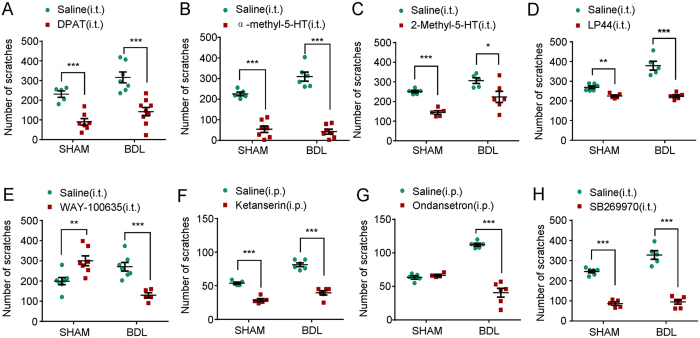
The effects of 5-HT receptors agonists or antagonists on 5-HT-induced scratching behavior in sham and BDL rats.(A–D) Scratching behavior induced by i.d. injection of 5-HT (200 μg) into the nape of the neck was significantly suppressed by intrathecal (i.t.) injection of 5-HT1A receptor agonist DPAT (A) 10 μg, 5-HT2 receptor agonist α-methyl-5-HT (B) 10 μg, 5-HT3 receptor agonist 2-Methyl-5-HT (C) 10 μg, 5-HT7 receptor agonist LP44 (D) 10 μg in sham and BDL rats (n = 6–8 per group). (E) Intrathecal (i.t.) injection of 5-HT1A receptor antagonist WAY-100635 (10 μg) increased 5-HT-induced scratching in sham rats, but suppressed that in BDL rats (n = 6–8 per group). (F) Intraperitoneal (i.p.) injection of 5-HT2 receptor antagonists ketanserin (1 mg/kg) could suppress 5-HT-induced scratching in both sham and BDL rats (n = 6–8 per group). (G) Intraperitoneal (i.p.) injection of 5-HT3 receptor antagonists ondansetron (3 mg/kg) can suppress 5-HT-induced scratching in BDL rats, but not sham rats (n = 6–8 per group). (H) Intrathecal (i.t.) injection of 5-HT7 receptor antagonist SB269970 (10 μg) could suppress 5-HT-induced scratching in both sham and BDL rats (n = 6–8 per group) (*P < 0.05, **P < 0.01, ***P < 0.001 vs. vehicle values and analyzed by Student’s t-test).